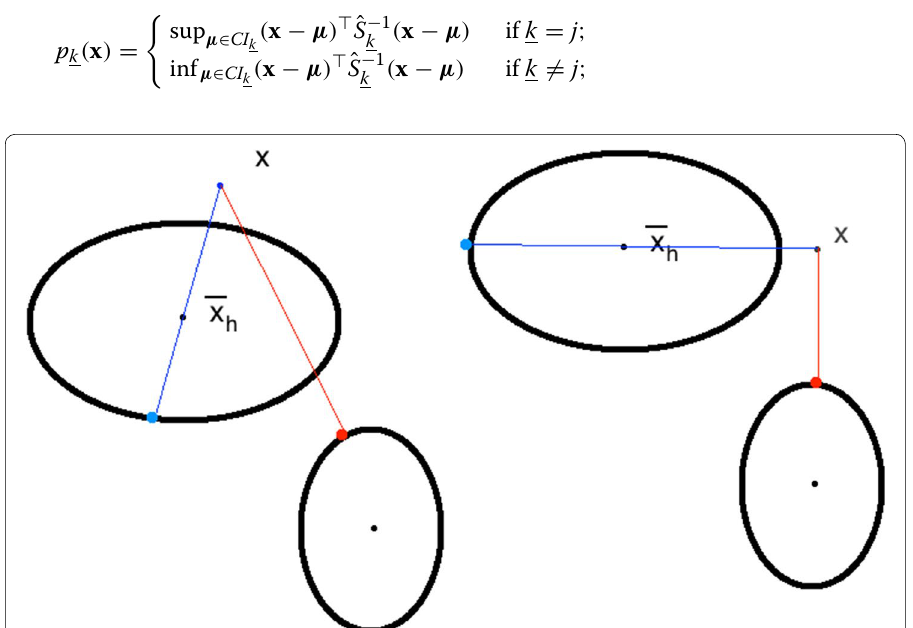
Fig. 2 The two possible situations after the perturbation of the clusters centers. Left: the point x is assigned to cluster h ; right: x is moved to